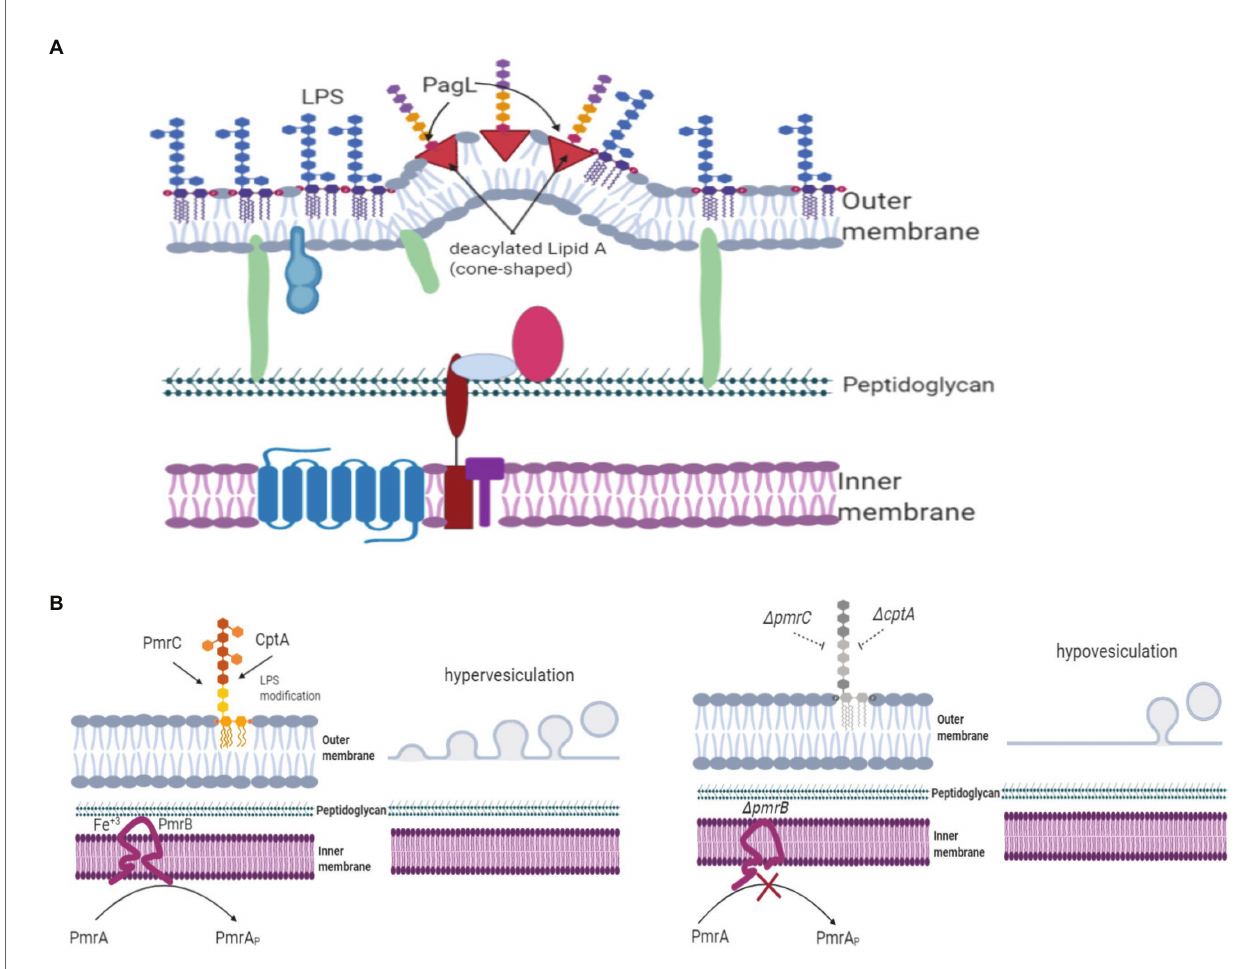
FIGURE 2 | LPS modifications are implicated in OMV release. Negatively charged LPS causes an outer membrane imbalance, subsequent membrane protrusion, and OMV release. LPS modifications also contribute to OMV formation. (A) The S. typhimurium strain expressing PagL without the PhoPQ control produces more OMVs than the wild-type strain. The outer membrane of S. typhimurium expressing PagL shows that hexa-acylated lipid A is predominant, while OMVs primarily contain penta-acylated lipid A. Thus, either the cylindrical or inverted-cone shape decreases hydrophobic interactions, leading to membrane protrusion and favoring OMV formation. (B) Citrobacter rodentium uses a two-component system to modify LPS. PmrB, a member of this system, senses high Fe +3 concentrations and regulates the modification of lipid A. C. rodentium ΔpmrB cannot add groups to lipid A, leading to increased